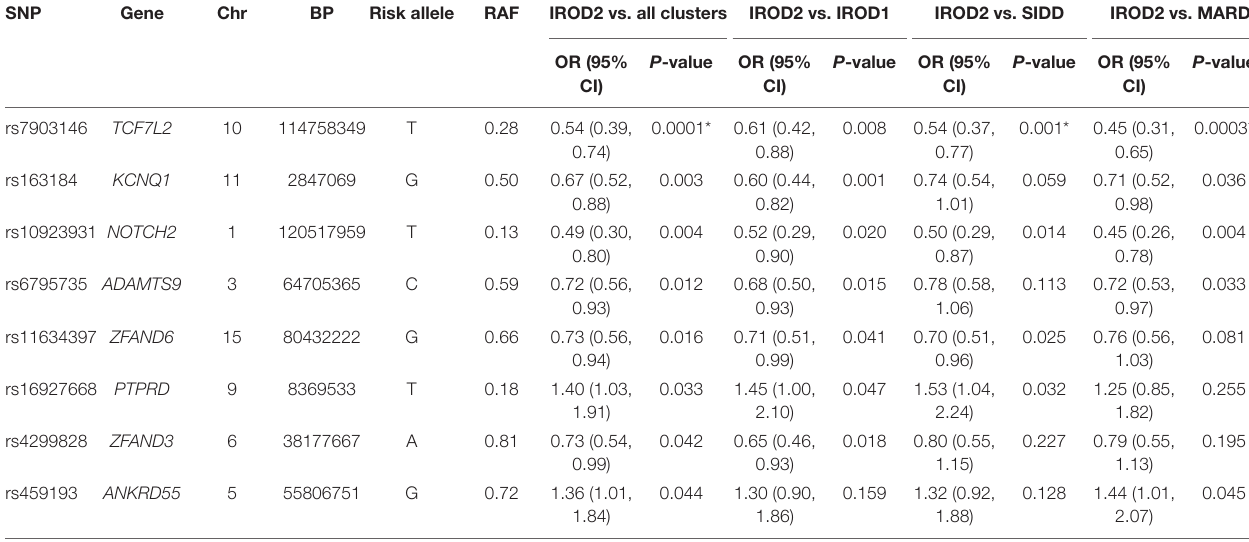
TABLE 3 | Top T2D SNPs nominally associated with IROD2 cluster in individuals with long-term diabetes. SNP Gene Chr BP Risk allele RAF IROD2 vs. all clusters IROD2 vs. IROD1 IROD2 vs. SIDD IROD2 vs.